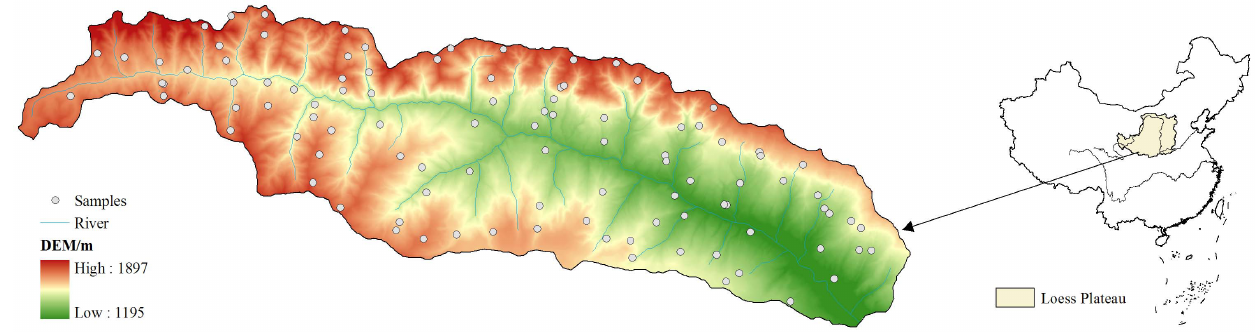
Figure 1. Location of the study area and distribution of the sampling points.